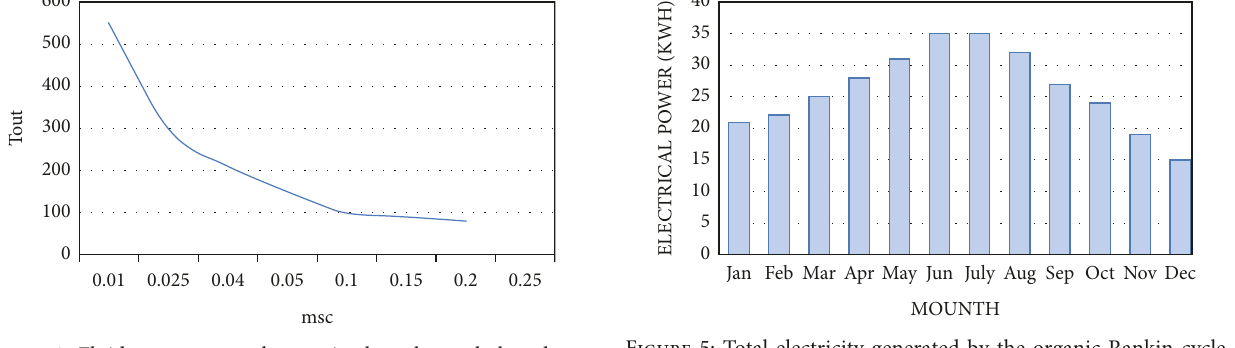
Figure 2: Fluid temperature changes in the solar cycle based on mass flow.